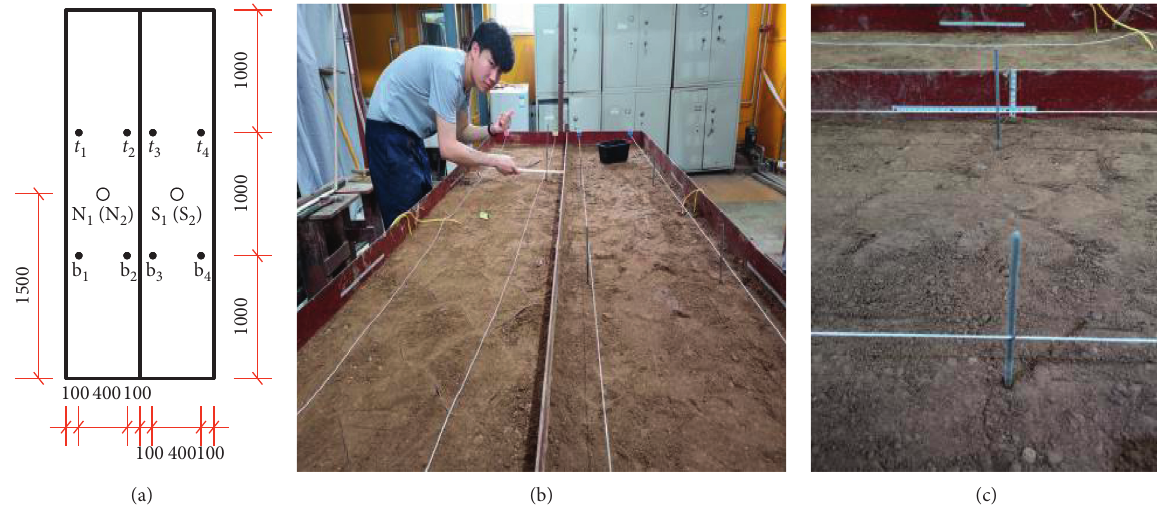
Figure 5: Placement of measurements: (a) schematic to show positions of marking rods and water content testing devices; (b) marking string to facilitate the slope displacement measurement; (c) positioning rods.